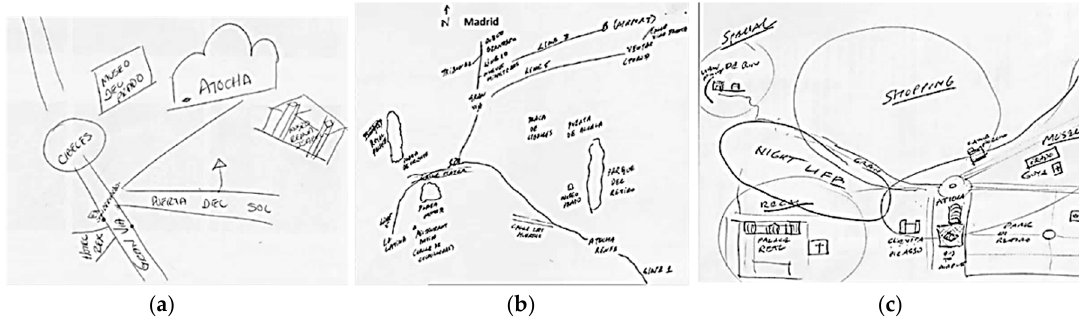
Figure 5. Features portrayed in the sketches: ( a ) POIs in 2D (Atocha train station) and 2.5D (Reina Sofía museum); ( b ) POIs structured around the metro lines; ( c ) zones related to spatial tasks.